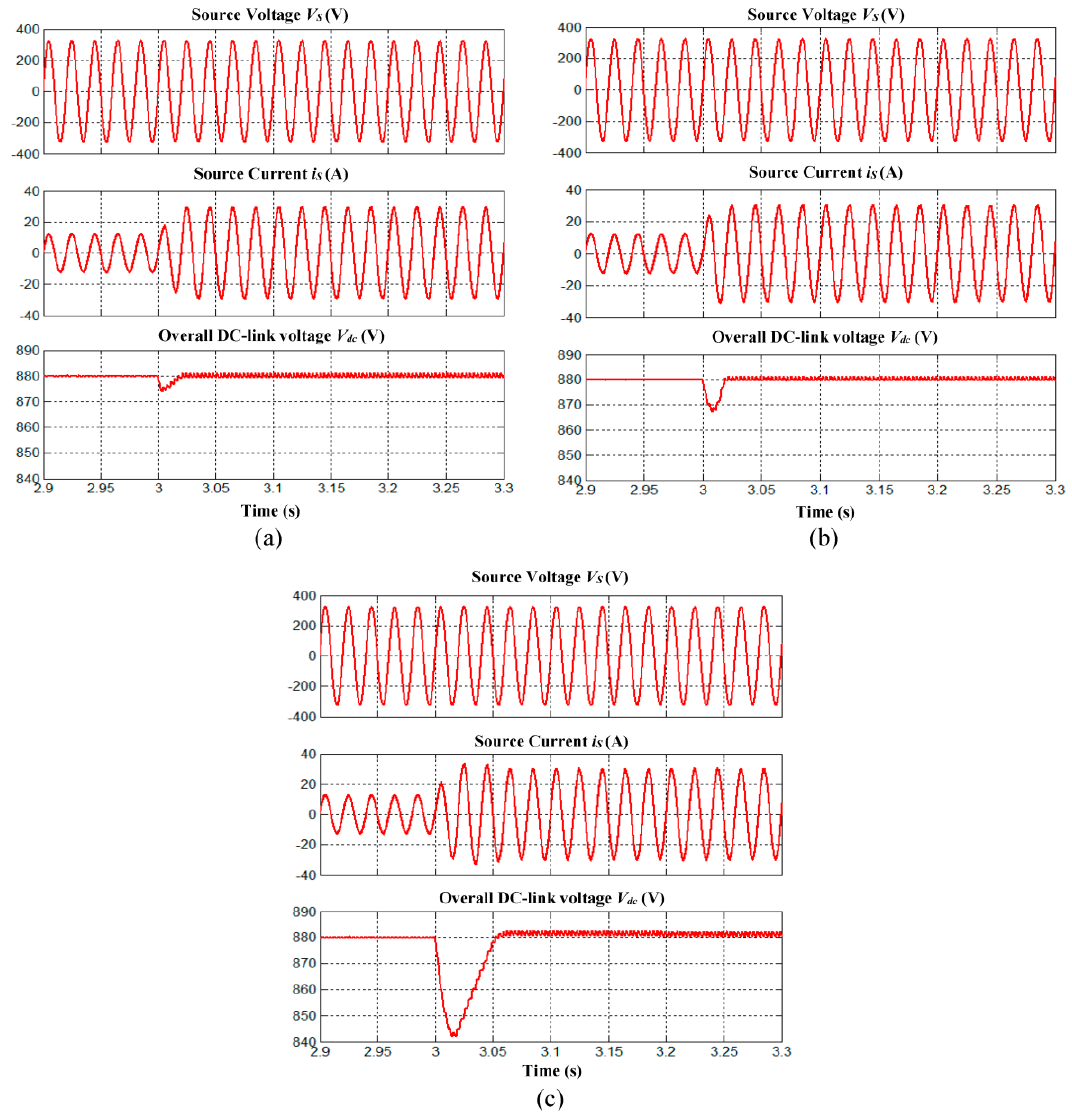
Figure 11. Simulation results of SAPF which include source voltage 𝑣 𝑆 (phase A), source current 𝑖 𝑆 (phase A) and overall DC-link voltage 𝑉 𝑑𝑐 for dynamic-state condition of inductive to resistive load obtained using ( a ) the proposed algorithm with IED control; ( b ) the conventional algorithm with FLC and ( c ) PI techniques.